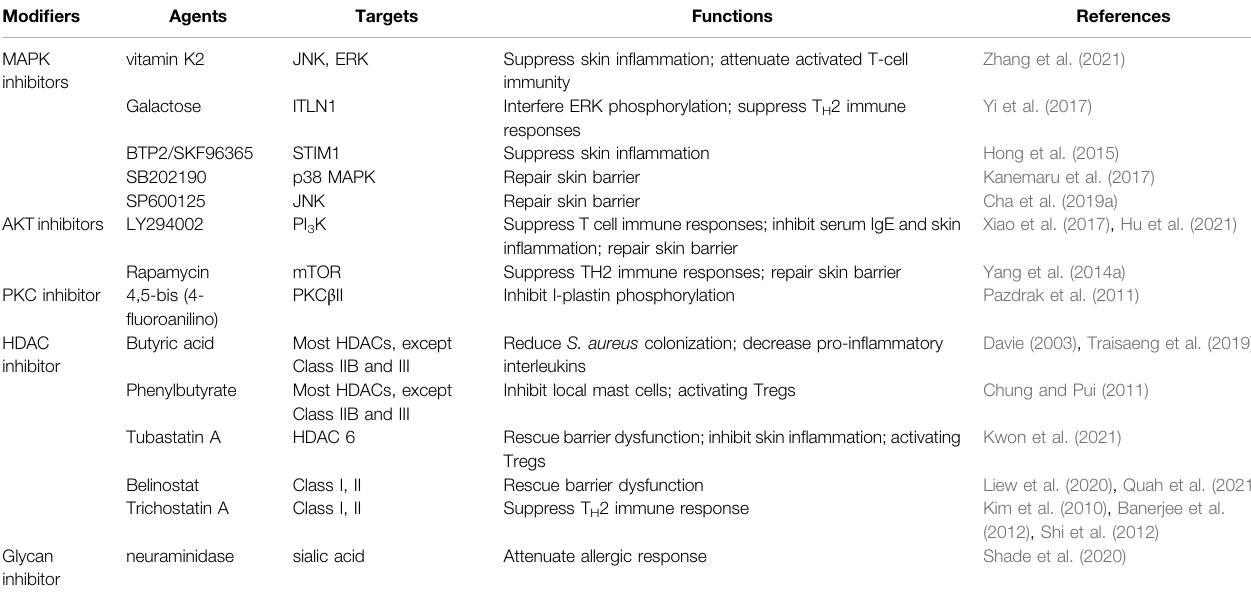
TABLE 2 | Potential therapeutic target in AD associated with protein post-translational modi fi